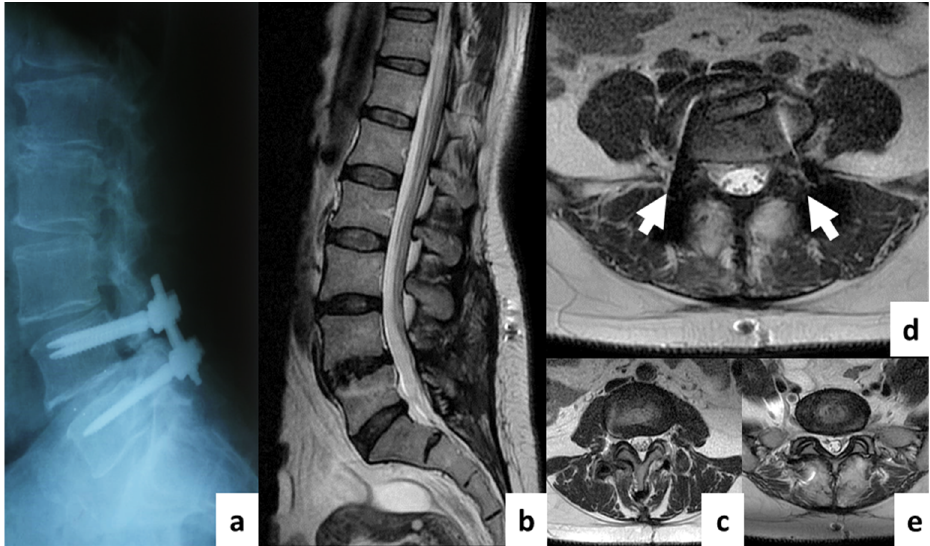
Figure 2. Postoperative T2w MRI of a 50-year-old female from group I with degenerative disc disease at L4–L5. ( a )—sagittal X-ray; ( b )—sagittal MRI; ( c )—axial MRI at L3–L4 (overlying segment); ( d )—axial MRI at L4–L5 (operation level); ( e )—axial MRI at L5–S1 (underlying segment). The white arrows indicate regions with visible artifacts.